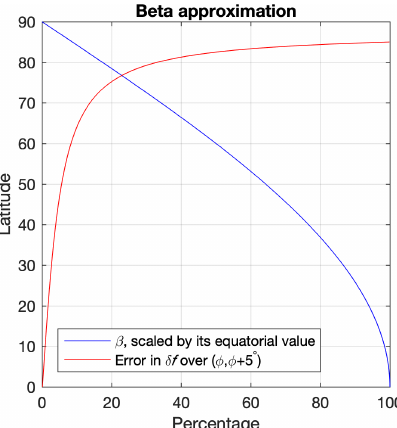
Figure 3. Variation in latitude of β and also the error in δf over a distance of 5 ◦ poleward of a given latitude when using the β -plane